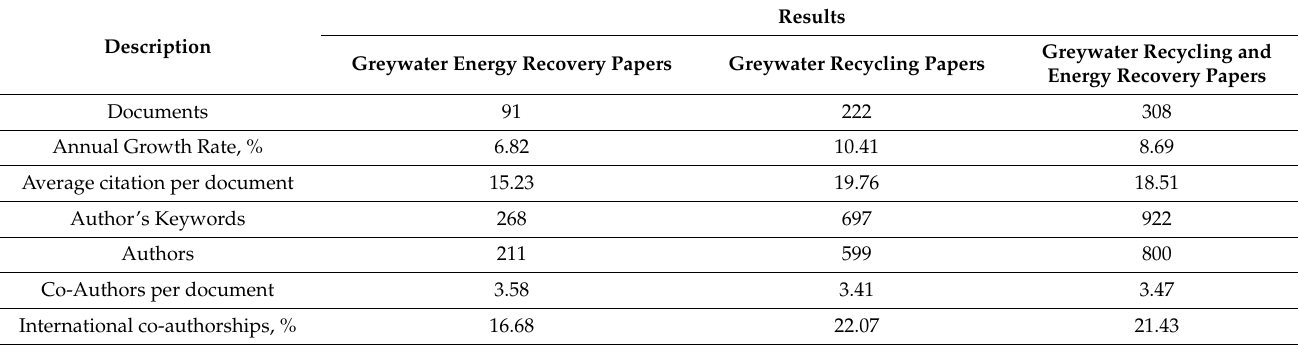
Table 12. Basic information on the analyzed groups of